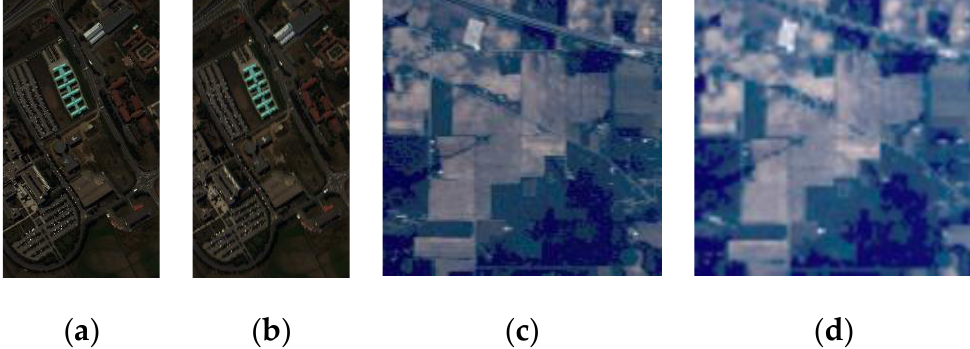
Figure 25. False color maps of the Indian Pines and Pavia University datasets. ( a ) and ( c ): original datasets; ( b ) and ( d ): downsampled datasets.